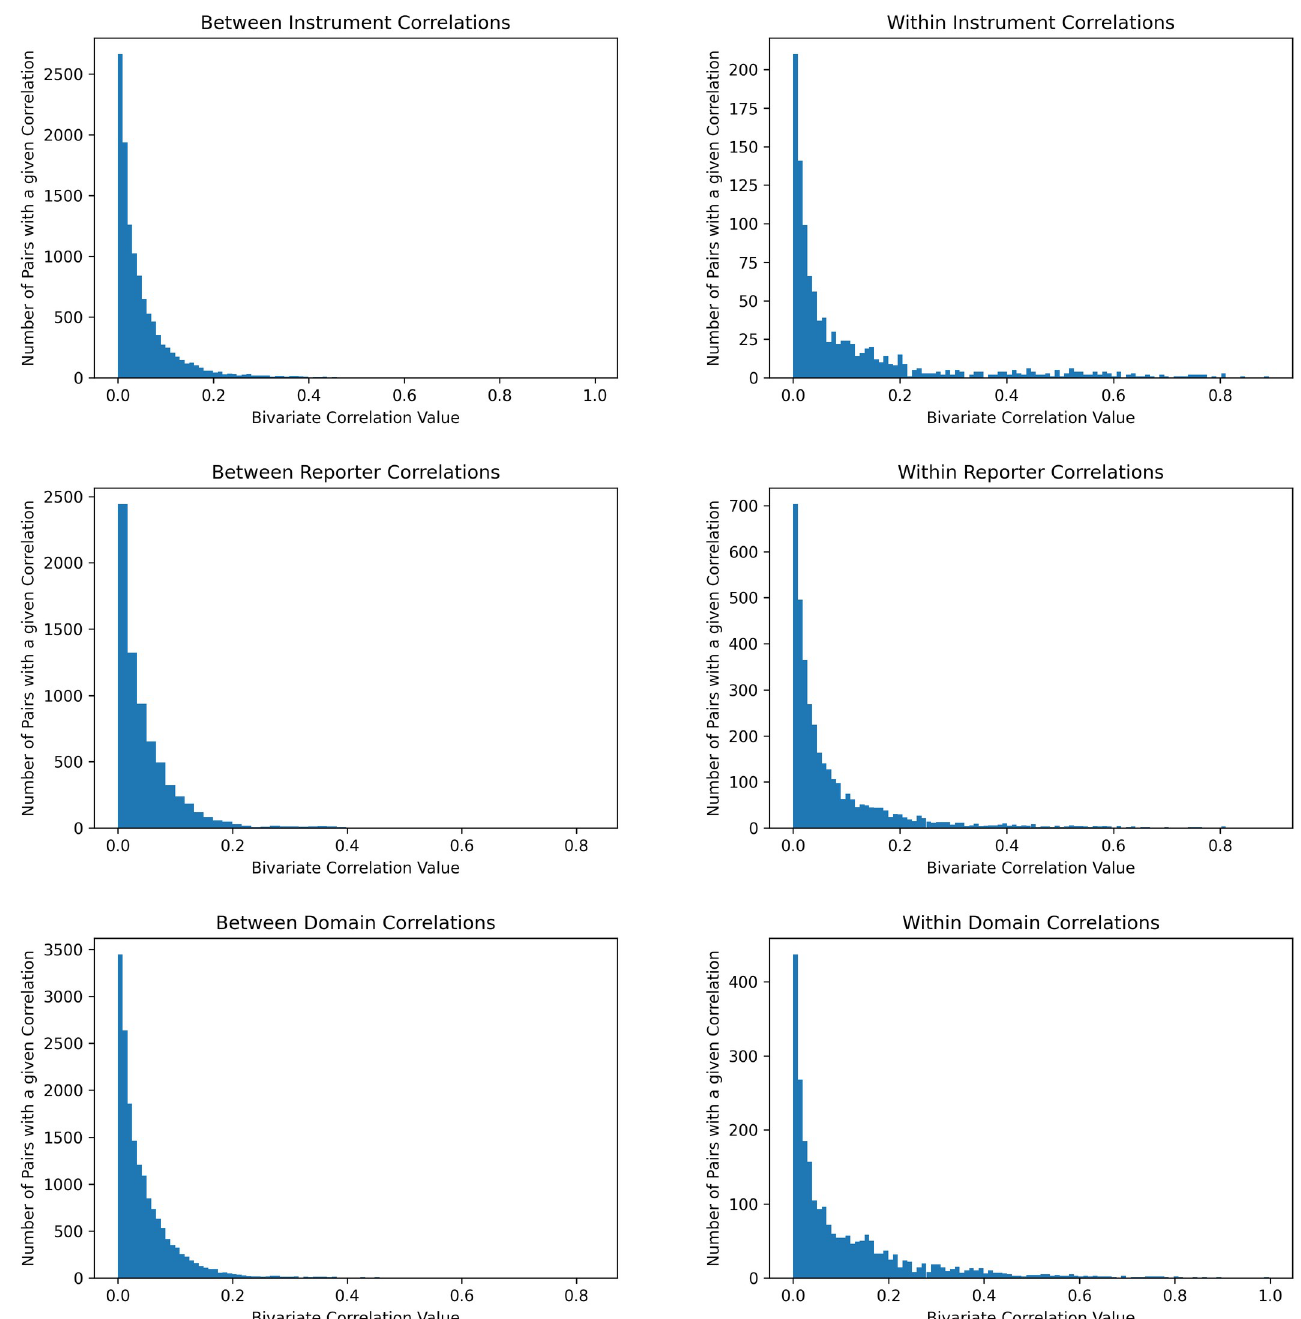
Fig 3. Qualifications of effect size